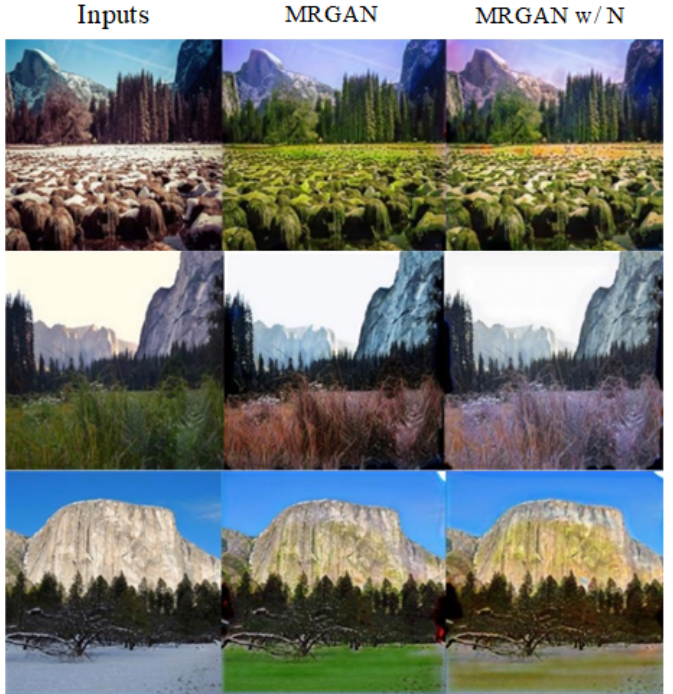
Figure 9. The effects on results using different initializations after five rounds. From left to right: input images, the results using Xavier parameter initialization, and the results using Gaussian